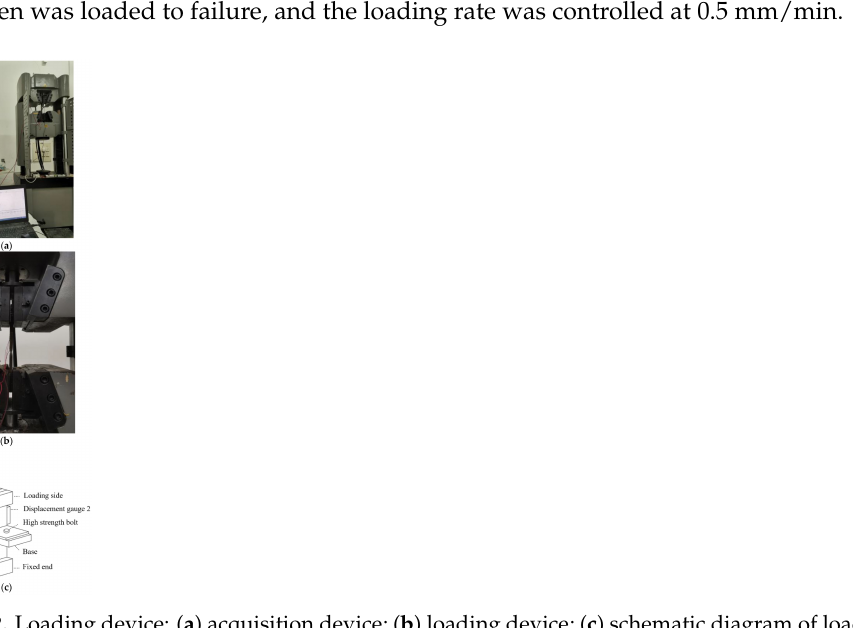
Figure 2. Loading device: ( a ) acquisition device; ( b ) loading device; ( c ) schematic diagram of loading. Table 2. Material property test